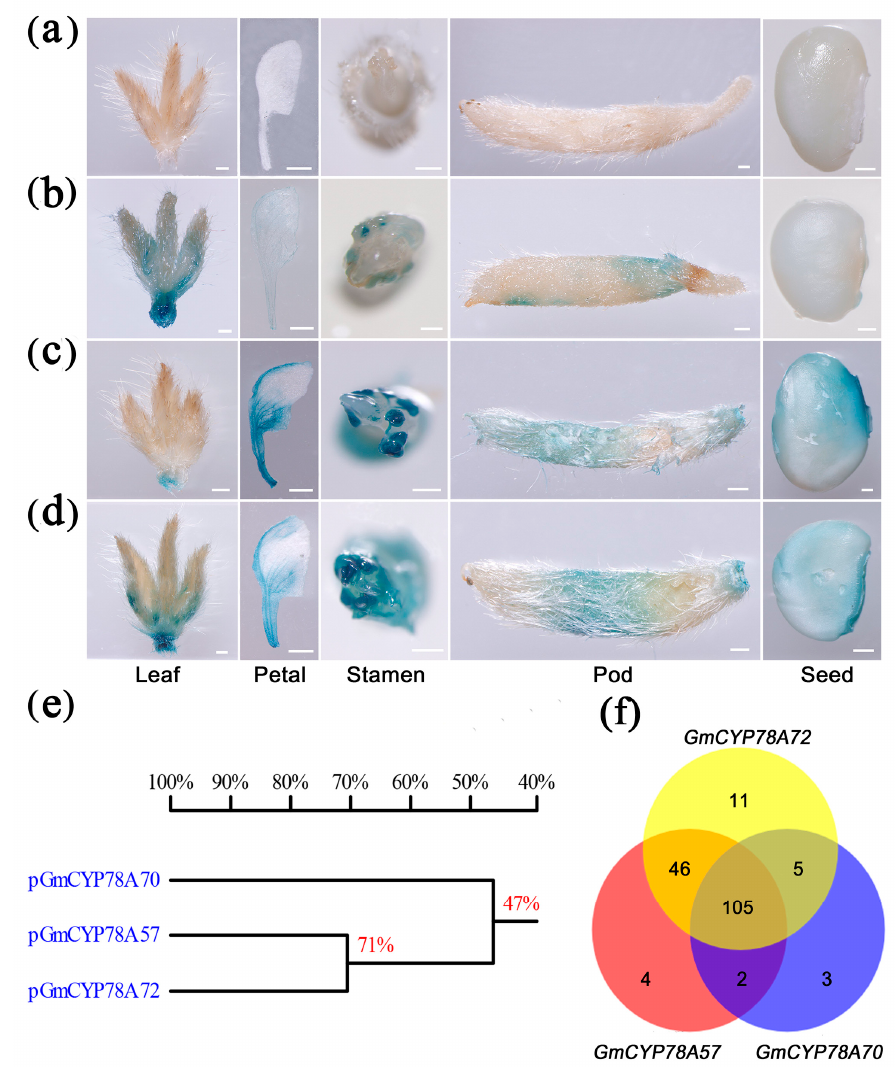
Figure 4. GmCYP78A s expression activities were monitored by pGmCYP78As::GUS transgenic expression. ( a – d ) Respective histochemical analyses of the control, pGmCYP78A70::GUS , pGmCYP78A57::GUS and pGmCYP78A72::GUS in developing trifoliate leaflets, petals, stamen, pod trichome and seeds. Scale bars = 1 mm in (a–d). ( e ) Comparison of the promoters of the GmCYP78A homologues of the gene. ( f ) Venn diagram of the transcription factors that could bind to the GmCYP78A s promoters.